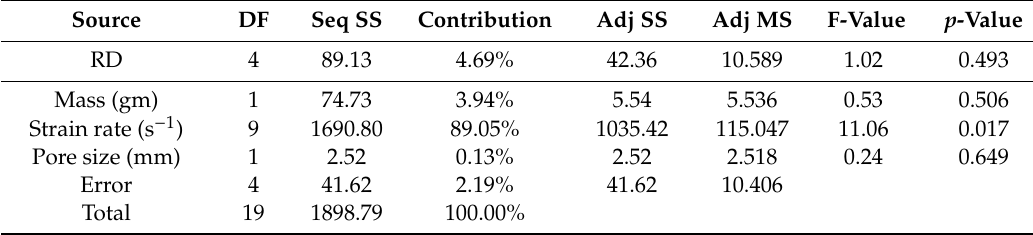
Table 2. Results obtained from ANOVA